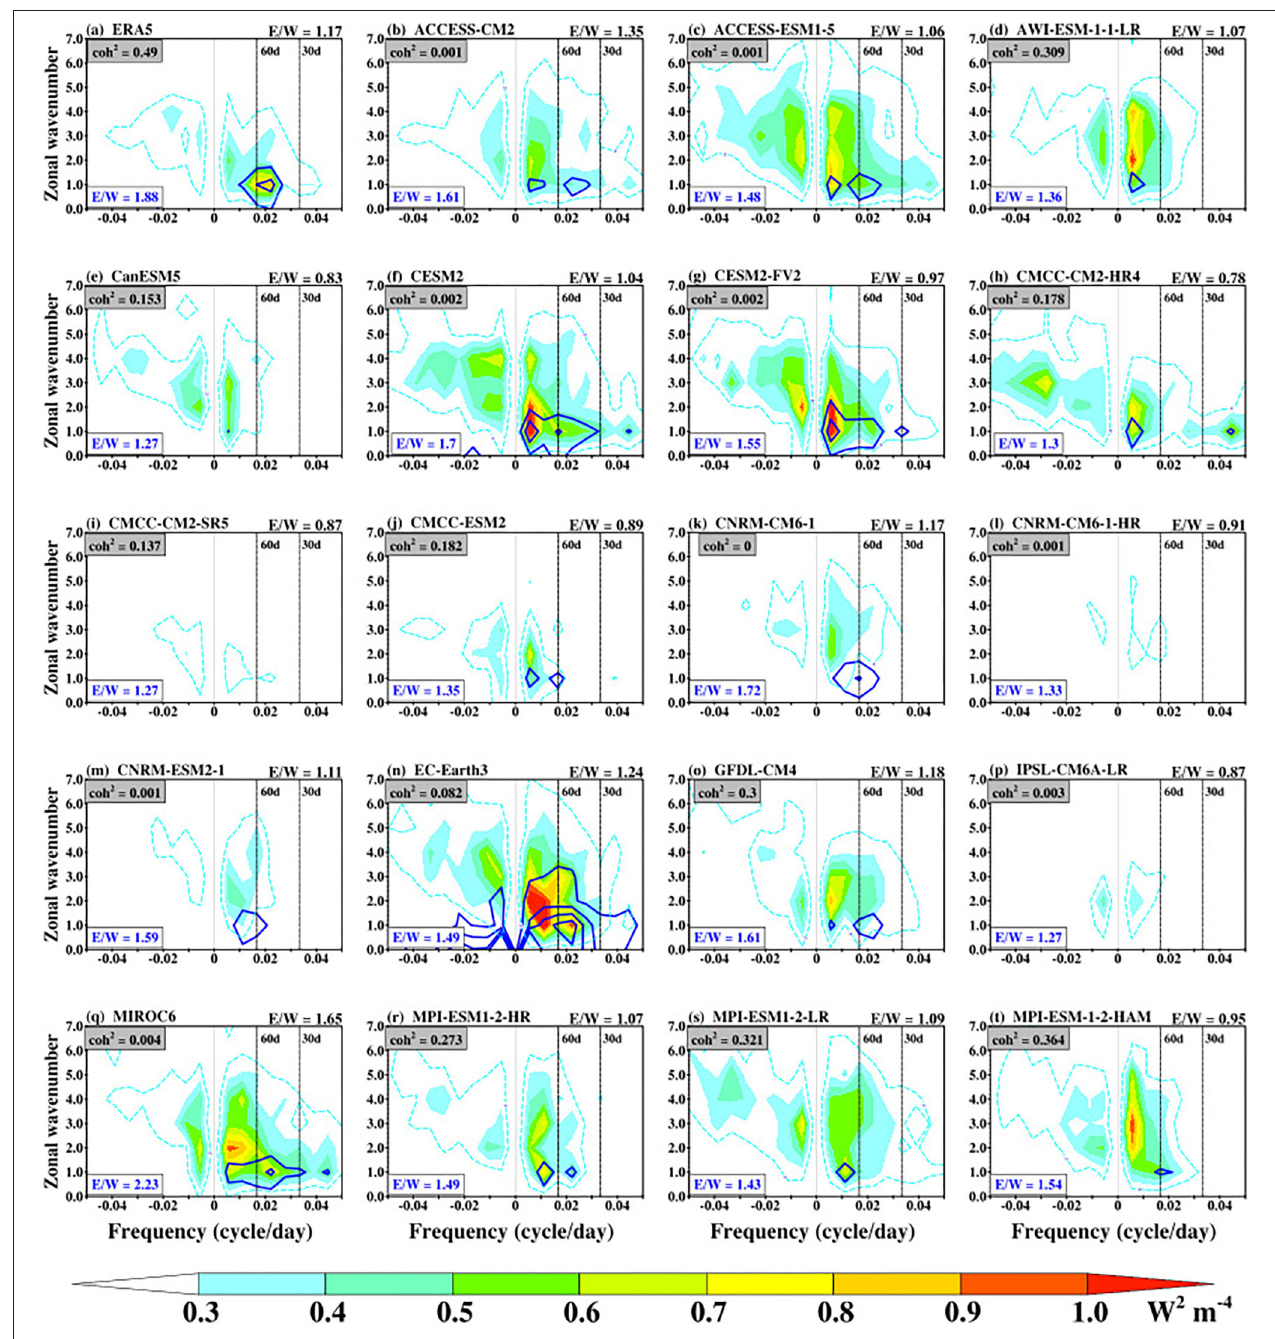
FIGURE 3 | Zonal wavenumber-frequency power spectra of the boreal summer (May–October) intraseasonal OLR (shaded) and 850-hPa zonal wind [blue contours; (m s − 1 ) 2 , with contours from 0.02 at an interval of 0.02] anomalies from observations ( a ; OLR and ERA5) and CMIP6 models (b–t) over 10 ◦ S − 30 ◦ N domain. The cyan dotted contour represents the 0.2 (W m − 2 ) 2 isoline of OLR. Periods of 30 days and 60 days are indicated by the vertical dashed lines. Positive frequencies indicate eastward propagating waves and negative frequencies indicate westward propagating waves. The ratio of OLR eastward propagating wave to westward propagating wave (E/W) is shown at the top panel, while that of the zonal wind is shown at the bottom left (blue). The coherence-squared (Coh 2 ) of OLR and 850-hPa zonal wind averaged over 10 ◦ S − 30 ◦ N is shown at the upper left corner of the plot. respectively), which signify the robustness of the BSISO eastward obtained as the ratio of the sum of eastward power spectra to the propagation. As indicated by the blue contours in Figure 3a , the sum of westward power spectra over the 30–60-day band. The observed eastward-propagating U850 spectrum is consistent observed E/W ratio is > 1 (1.26 and 1.17 for NOAA and ERA5,